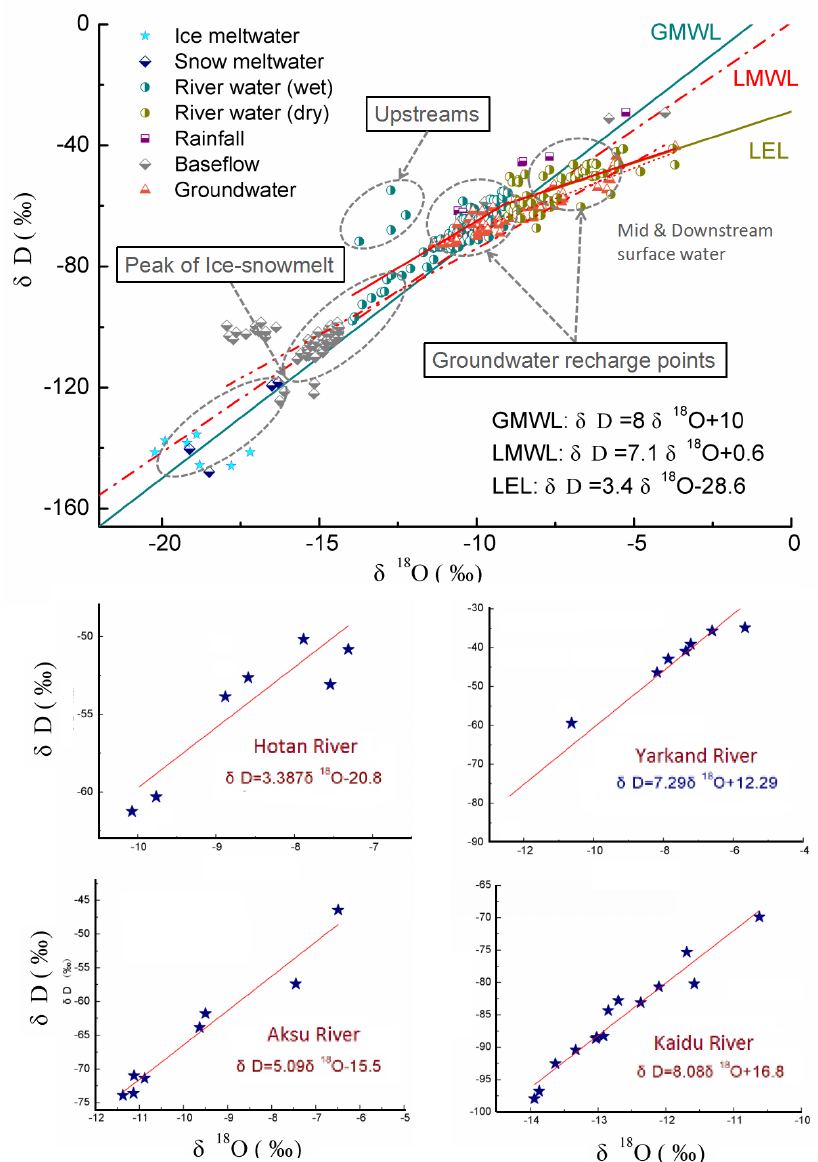
4 Figure 4. Water components’ relationship displayed by the bivariate plot of δ D versus δ 18O in Tarim River Basin, with river water, precipitation, ice-snowmelt water and groundwater relative to global meteoric water line (GMWL) [25] and local meteoric water line (LMWL) [26]. The isotopic composition of the surface water is plotted on a local evaporation line (LEL). Surface water lines of the four headstreams were